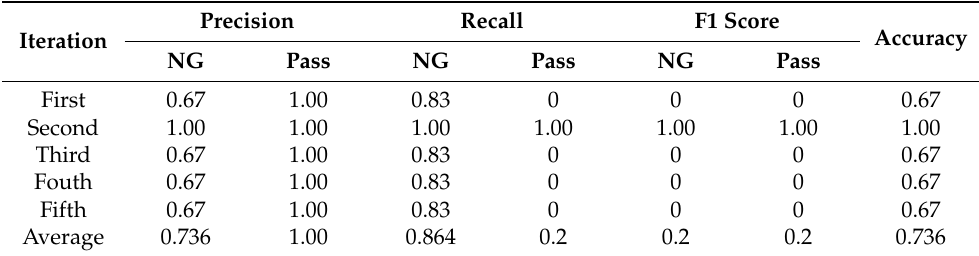
Table A5. LeNet with K-fold + (1 × 1) Convolution Iterations.